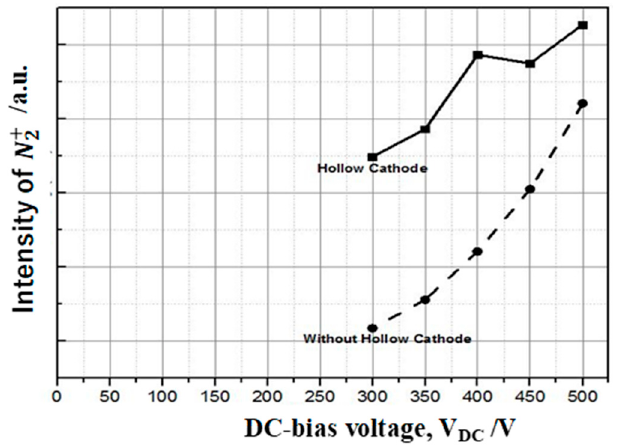
is a necessary condition in this RF-DC plasma, nitriding at a low holding temperature.